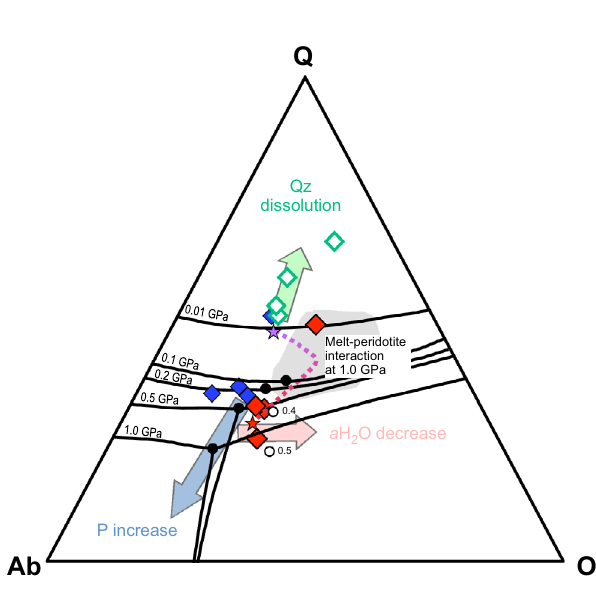
Fig. 4 | Ternary quartz-albite-orthoclase diagram illustrating normative com- positions of melt inclusions and interstitial glasses (corrected for normative anorthite after 4 ). Triangle apex are: Q quartz; Ab albite; Or orthoclase. The com- positionoftherhyolitemelt-peridotiteinteractiontrendmodelledbyMELTS(stars and dotted line) and the fi eld of rhyolite melt inclusions in Ronda peridotite 46 are shown for comparison. Eutectic and minimum points of the sub-aluminous hap- logranite system at aH 2 O=1.0 (black dots), 0.5 and 0.4 (white dots) are also reported (adapted from the literature 38,60 ). Abbreviations: Qz